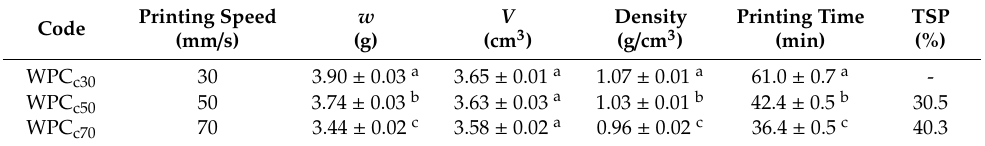
Table 3. Density and printing time of the compressive WPC parts printed at various printing speeds.